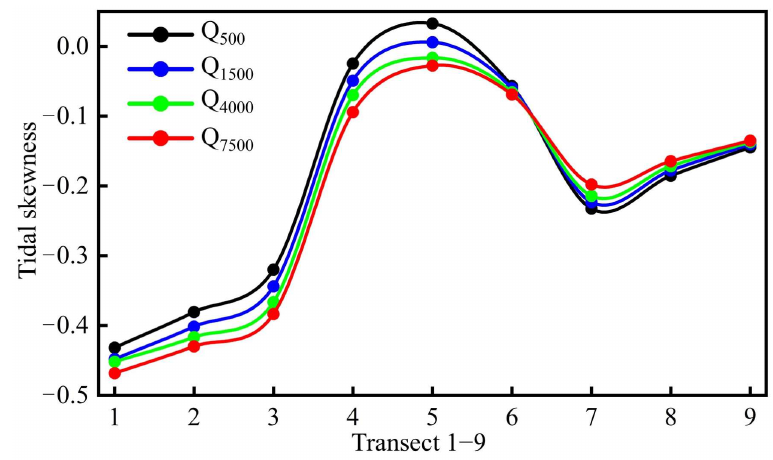
Figure 10. Tidal skewness of four runoff scenarios in the 9 cross-sections.